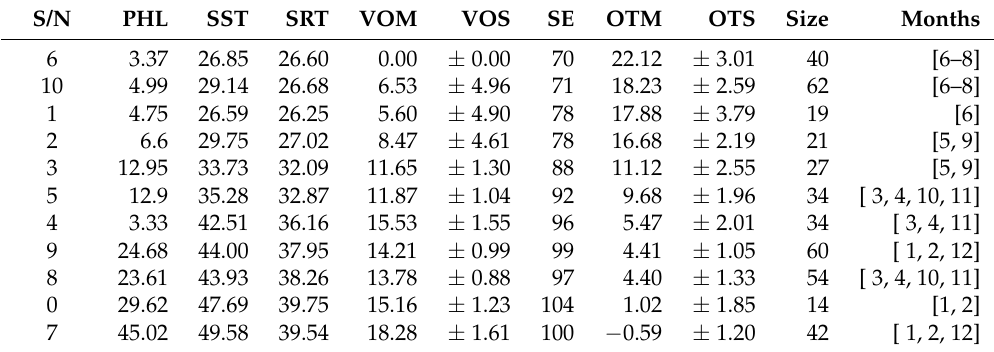
Table 7. Closed patterns from global model showing correlations between all three views after receiving chunk